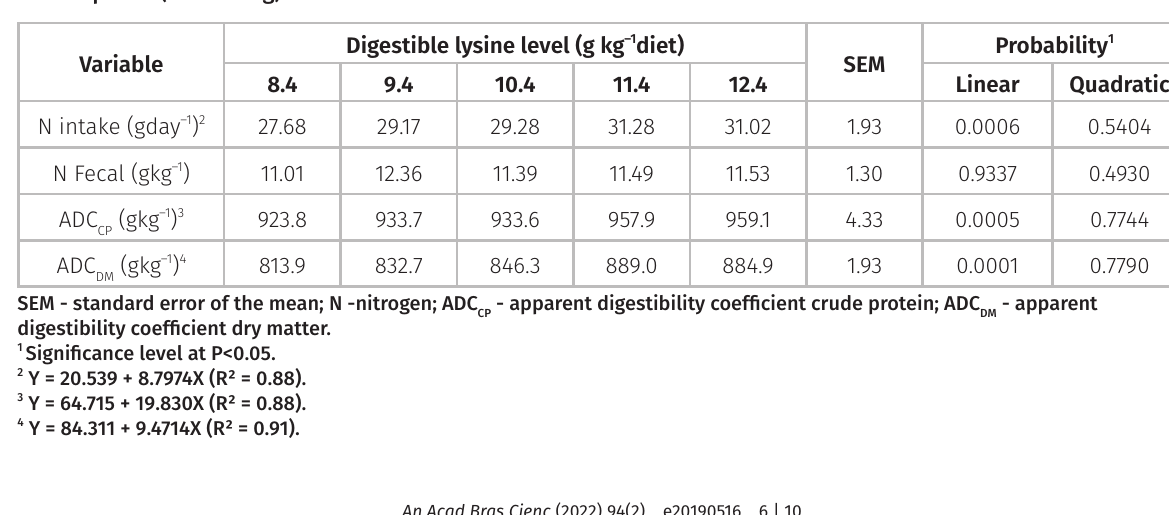
Table III. Effect of digestible lysine level on the apparent digestibility of nutrients in diets for barrows in the starter phase (15 to 30